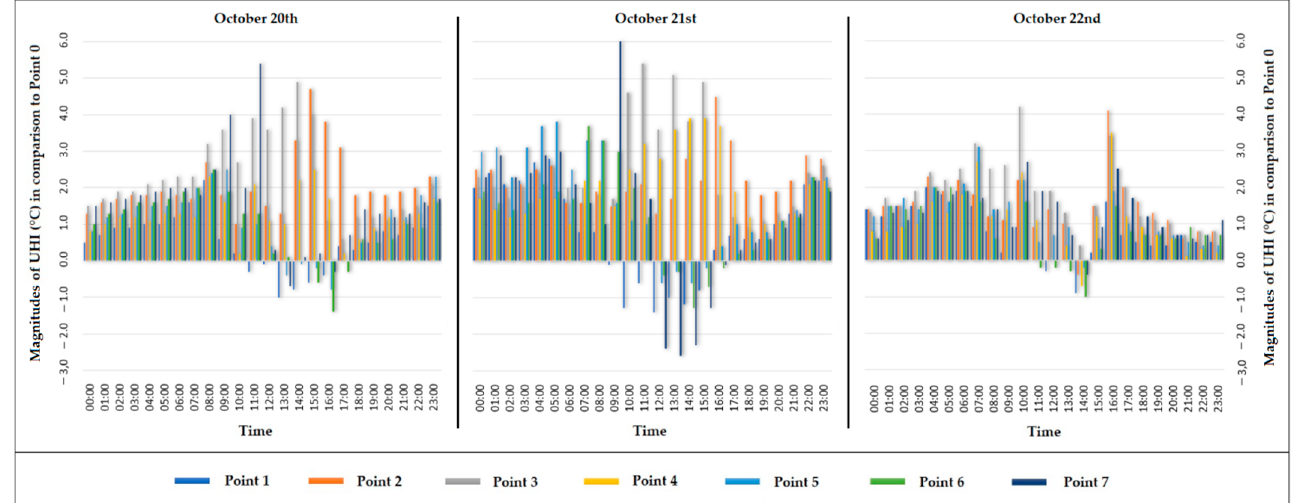
Figure 12. Hourly magnitude of the Ta and UHI of the seven points in Balneário Camboriú